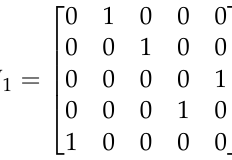
Figure 8 ) represents the critical values of the safety distance of the robot arm. The distance Ti d of the manipulator under each time node is calculated using Equation (5).